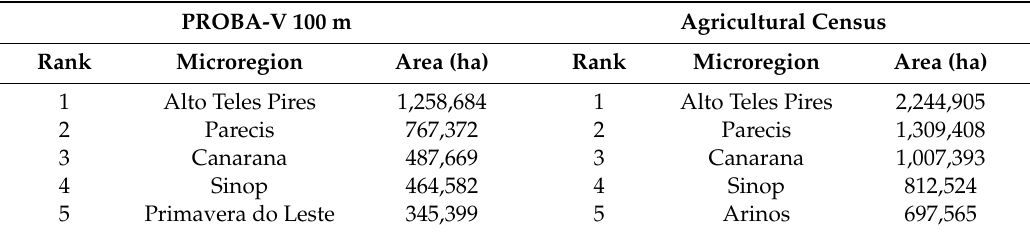
Table 2. Comparison between area estimation of annual croplands in the Mato Grosso State